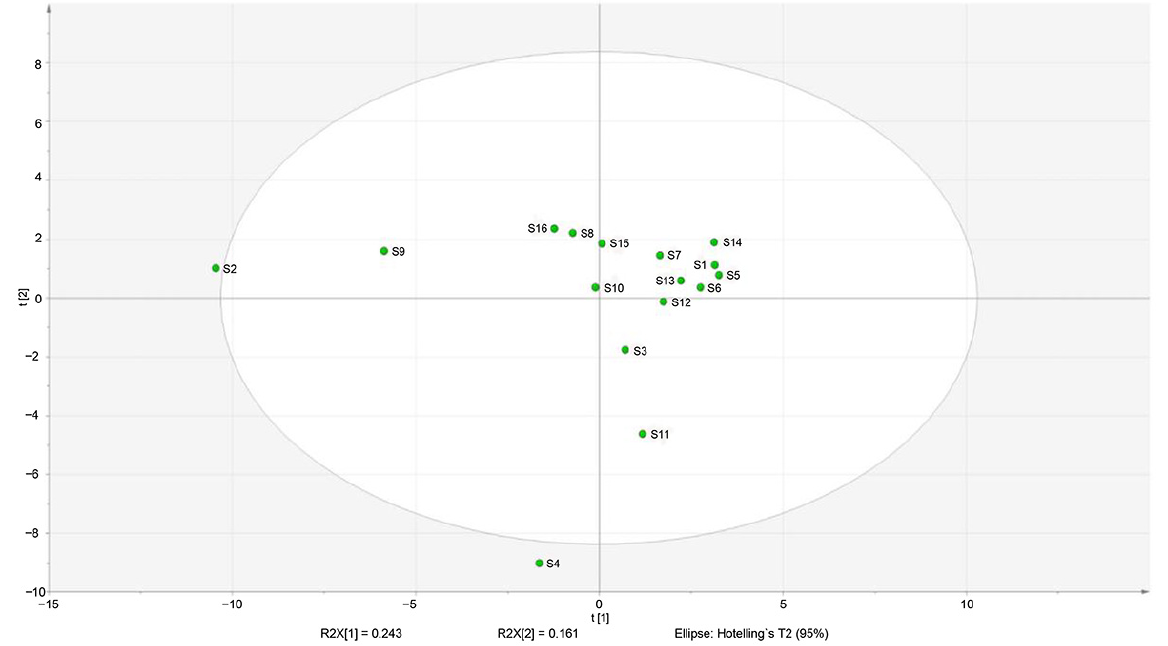
Foods 2022 , 11 , x FOR PEER REVIEW